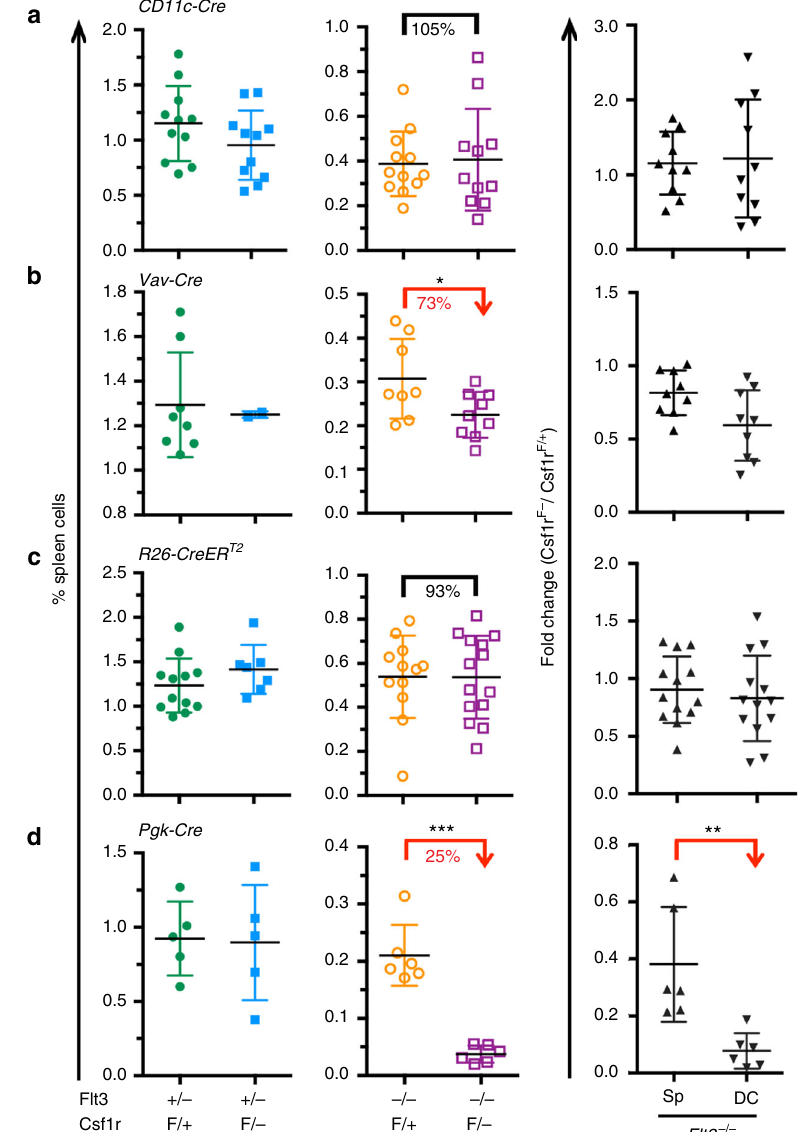
Fig. 2 CSF1R expression on mature DCs, or on any hematopoietic cell type, or on any cell in adult mice is not required for DC generation. a DC frequencies (left, middle) and fold-change differences of leukocytes and DCs (right) in the spleen from CD11c-Cre + ;Flt3 − / − ;Csf1r F/ − and control mice at 3 weeks of age. b DC frequencies and fold-change differences of leukocytes and DCs in the spleen from Vav-Cre + ;Flt3 − / − ;Csf1r F/ − and control mice at 3 weeks of age. c DC frequencies and fold-change differences of leukocytes and DCs in the spleen from adult R26-CreER T2 + ;Flt3 − / − ;Csf1r F/ − mice. Mice were tamoxifen (TAM) induced 6 – 8 weeks earlier at 8 – 12 weeks of age. Scheme of the experimental outline is shown in Supplementary Fig. 2d. d DC frequencies and fold-change differences of leukocytes and DCs in the spleen from Pgk-Cre + ;Flt3 − / − ;Csf1r F/ − and control mice at 3 weeks of age. Two-sided t tests (left) and Mann – Whitney U tests (right) were performed in all fi gure parts. SD is shown throughout the fi